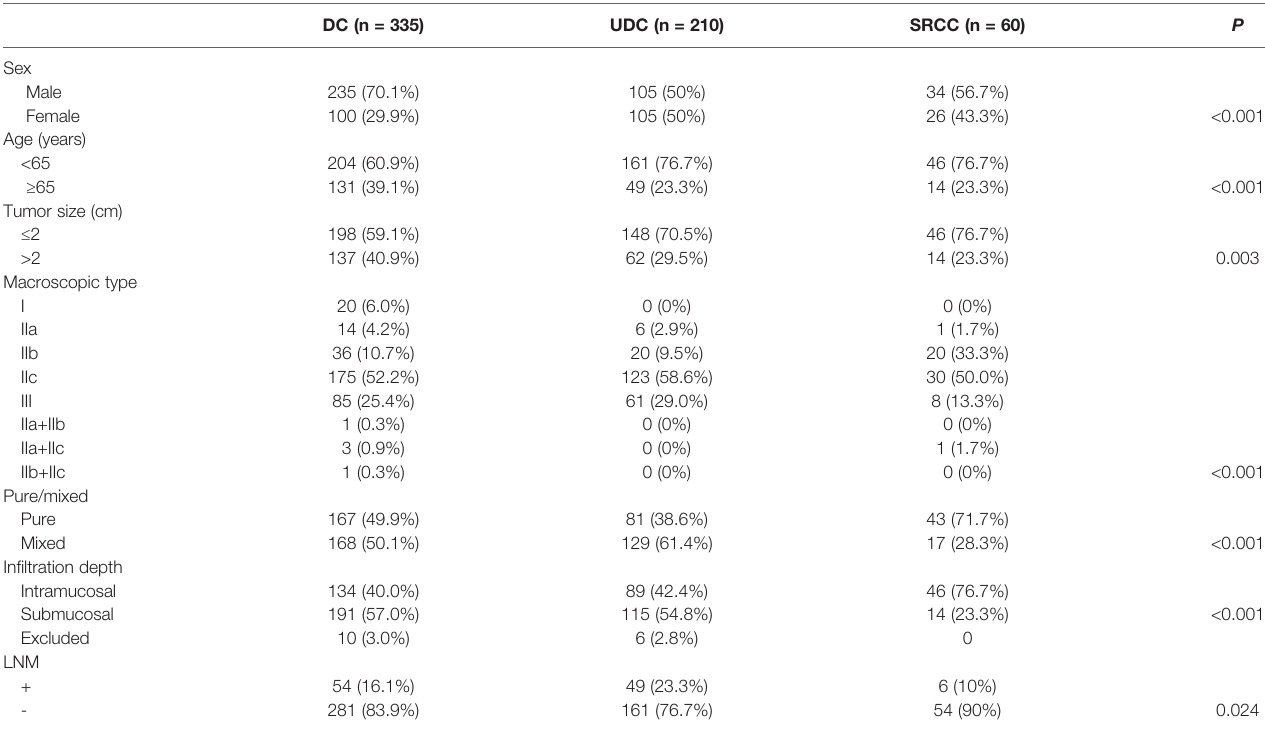
TABLE 3 | Clinicopathological characteristics of early cases of three pathological types.